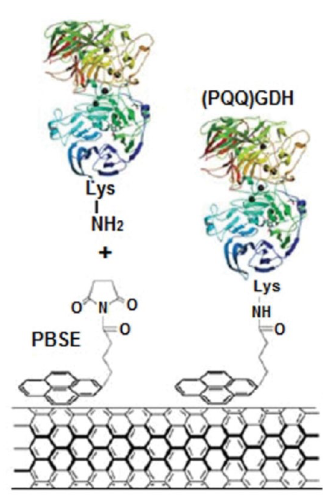
Fig. 16. Immobilization of the PQQ-GDH on carbon nanotubes with the help of the heterobifunctional linker PBSE